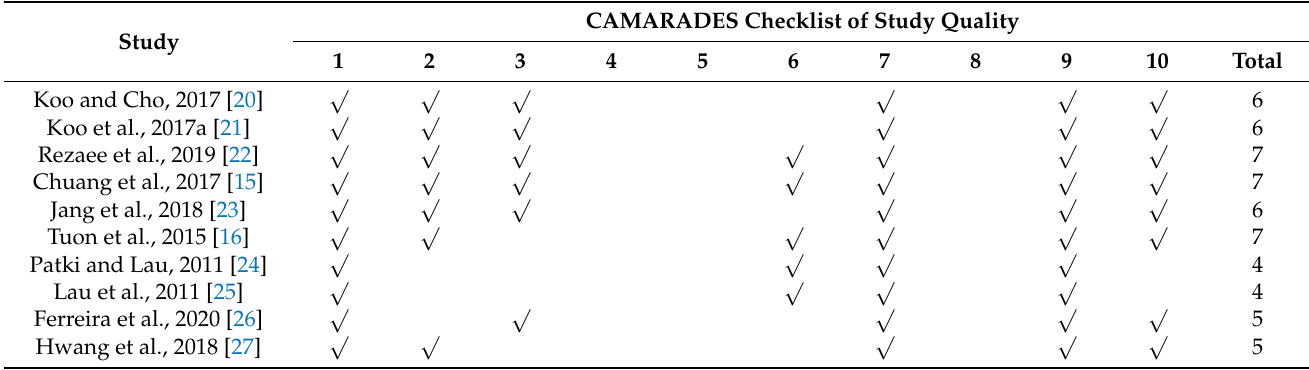
Table 2. The quality of studies basing-on the CAMARADES